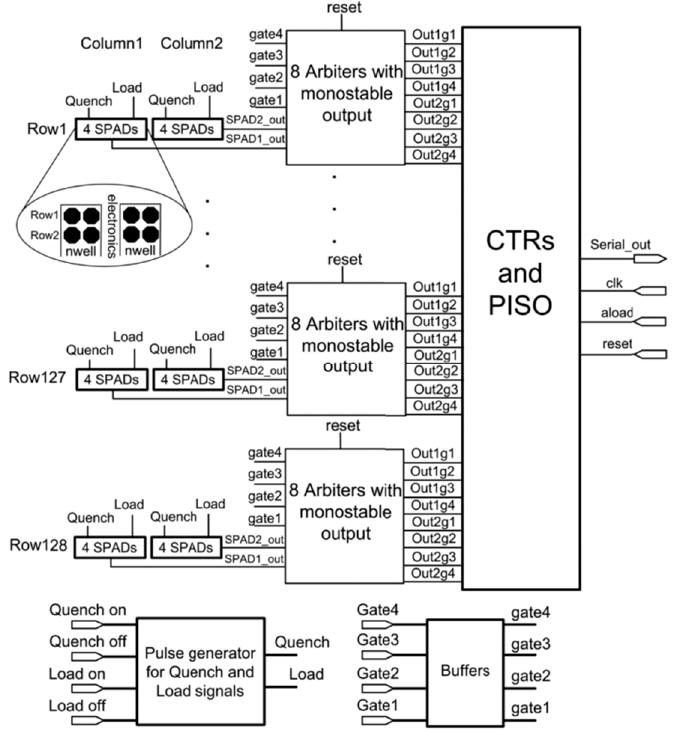
Figure 9. Block diagram of the multiphase time-gated SPAD line detector in